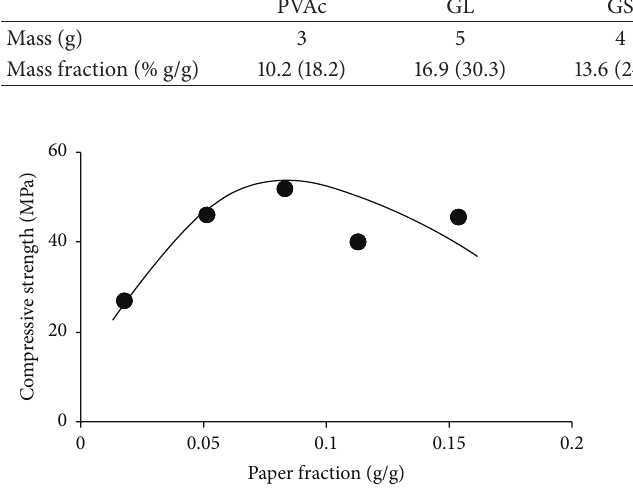
Figure 6: Effect of the paper mass fraction on the composite compressive strength. The other parameters used were as follows: 3 g of PVAc, 4 g of GS, 5 g of GL, 1.5 g of plastic, 1g of cloth, 13mL of water, and a hot-press temperature of 250 ∘ C.